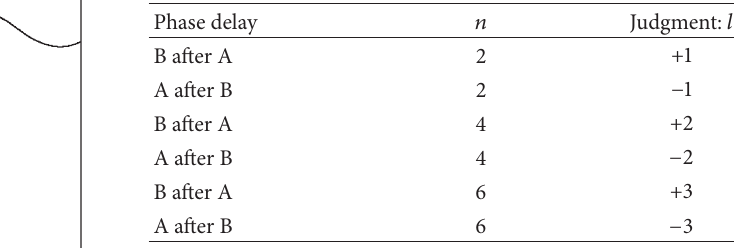
radio beam with mode number 𝑙 can be generated if the 𝑛 th element has phase 𝜙 𝑛 = 𝑙𝜑 𝑛 , where 𝜑 𝑛 = 2𝜋𝑛/𝑁 is the angle of the element position. In this paper, we assume that 𝑁 = 8 .